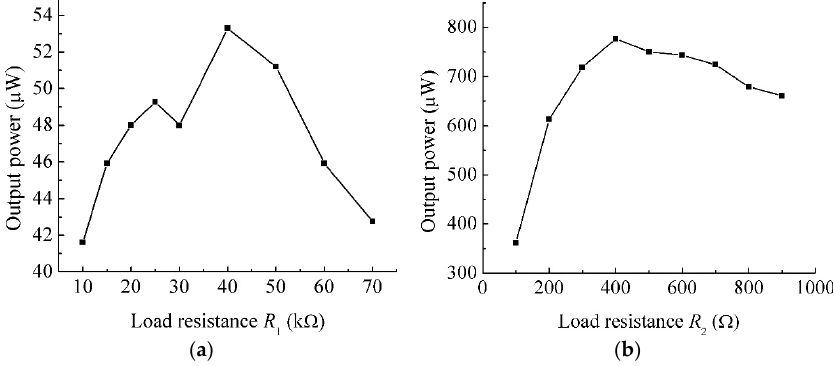
Figure 9. Output power of the FUCHEH with different load resistances. ( a ) The coil is open-circuit and R 1 varies; ( b ) The matched R 1 is connected to the piezoceramic patches and R 2 varies.